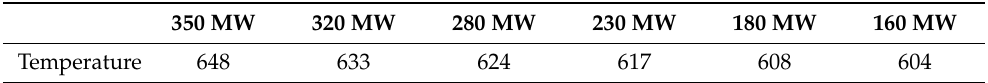
Table 4. The secondary air wind temperature table